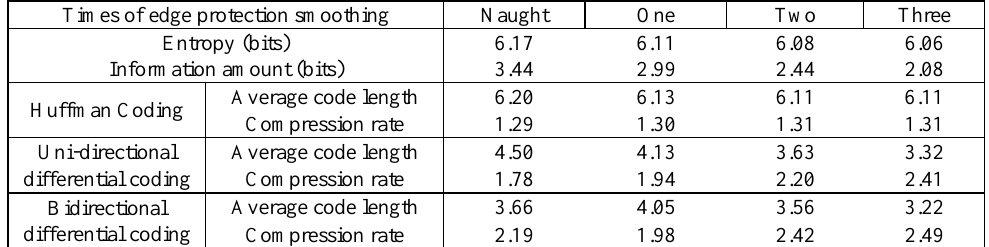
Table 4. Comparisons of Huffman coding and differential coding